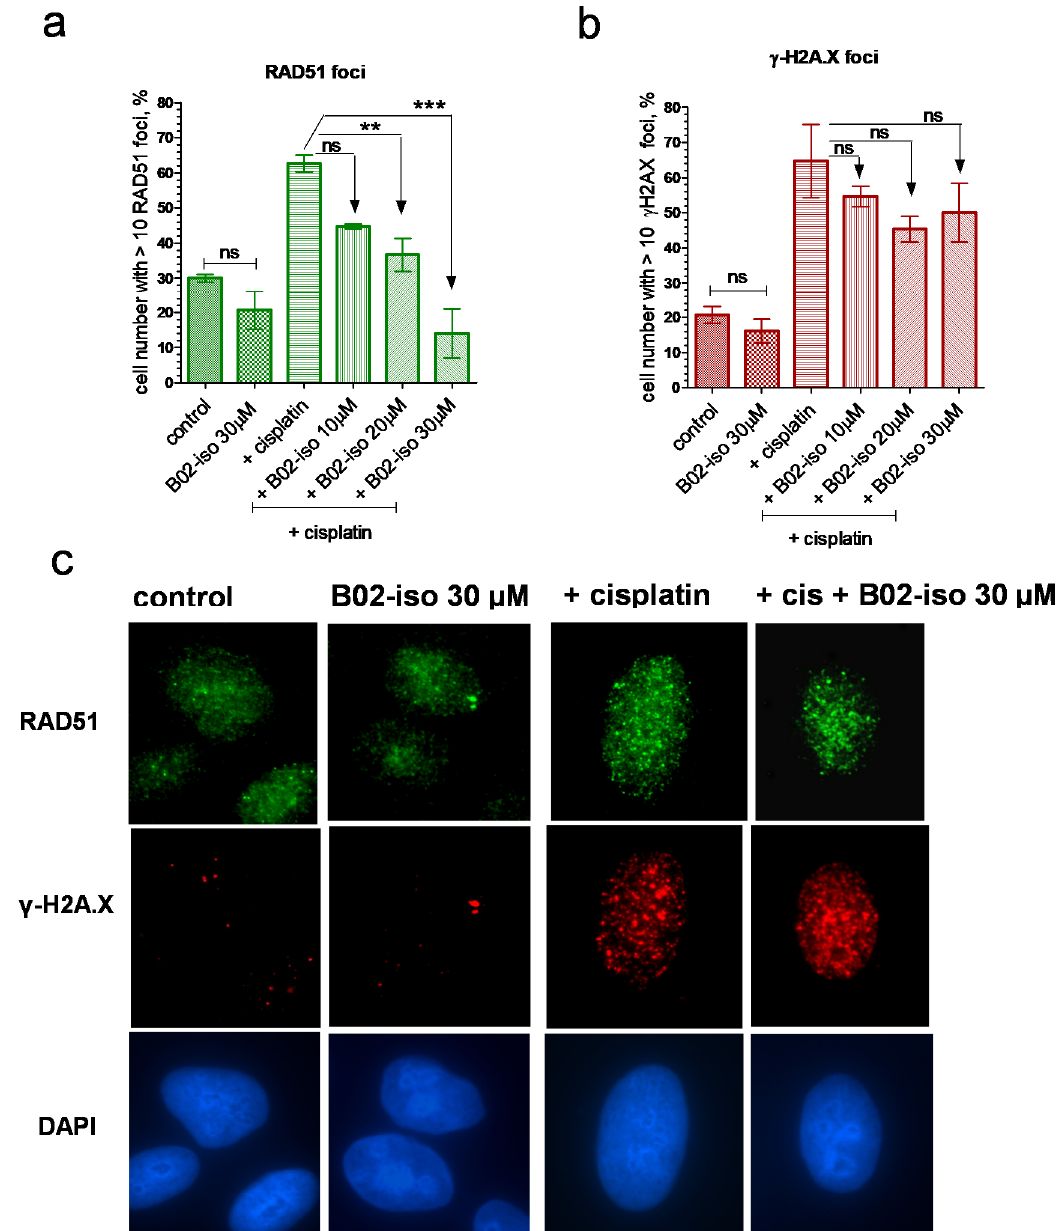
Figure 5. B02-iso inhibits RAD51 foci but not γ -H2A.X foci formation in U-2 OS cells in response to cisplatin treatment. ( a ) Percent of the cells bearing more than 10 RAD51 foci per nucleus in the cells either untreated (control), treated with B02-iso or with cisplatin or treated with B02-iso (in indicated concentrations) followed by treatment with cisplatin. ( b ) Percent of the cells bearing more than 10 γ -H2A.X foci per nucleus in the untreated cells (control) or treated with B02-iso or with cisplatin or with a combination of B02-iso and cisplatin as in ( a , c ), Typical images of the cells at indicated conditions stained with anti-RAD51 N1C2 antibody, anti- γ -H2A.X antibody and DAPI. cis—cisplatin. Error bars represent the SEM. Experiments were repeated at least 3 times. ** p < 0.01, *** p < 0.001, ns—not significant.